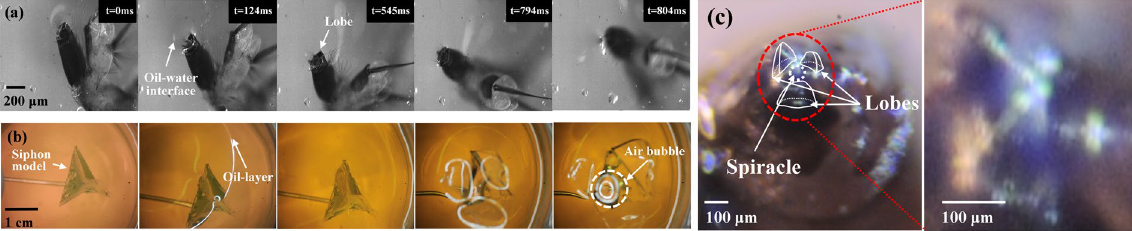
Figure 5. Dynamic behavior of the siphon of a mosquito larva at the oil-water interface under the application of oil-film. ( a ) Series of magnified images showing dynamic motion of the siphon of Ae. togoi mosquito larva at the oil-water interface. ( b ) Consecutive images showing dynamic motion of the siphon model in the region near the oil-water interface. ( c ) Occurrence of tracheal flooding caused by oil-film layer containing blue